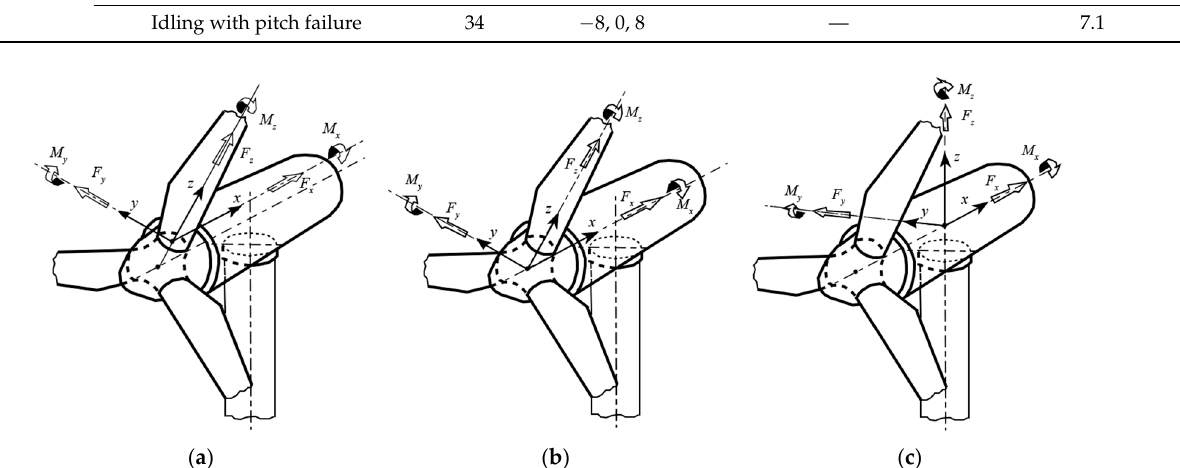
Figure 1. Coordinate systems for different loads: ( a ) Coordinate system for blade loads; ( b ) Coordinate system for hub loads; ( c ) Coordinate system for tower loads.